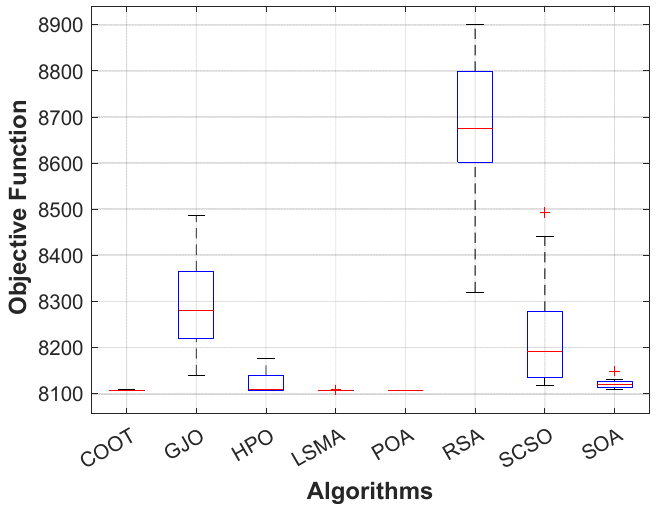
Figure 17. Boxplot of POA and other compared algorithms for case 5 in a standard IEEE 14-bus test system.